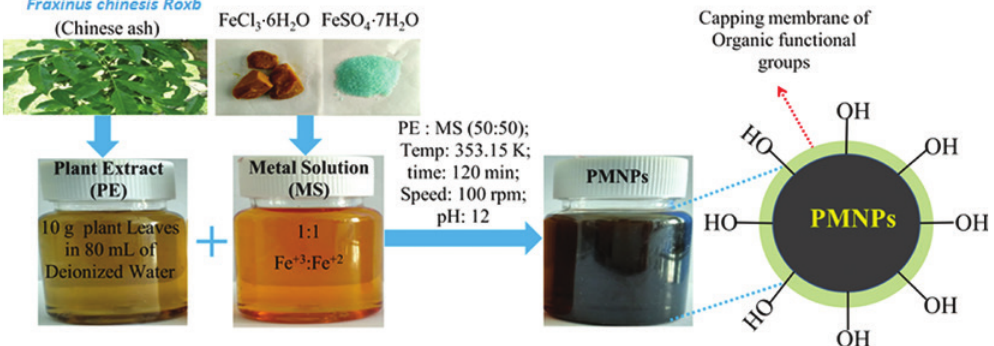
Figure 11: The fabrication scheme of the phytogenic magnetic nanoparticles (PMNPs). Reproduced from Ali et al. (2018) with permission from Royal Society of Chemistry,